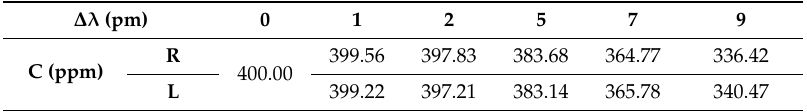
Table 4. Inversion error analysis of different shifts of wavelength in the